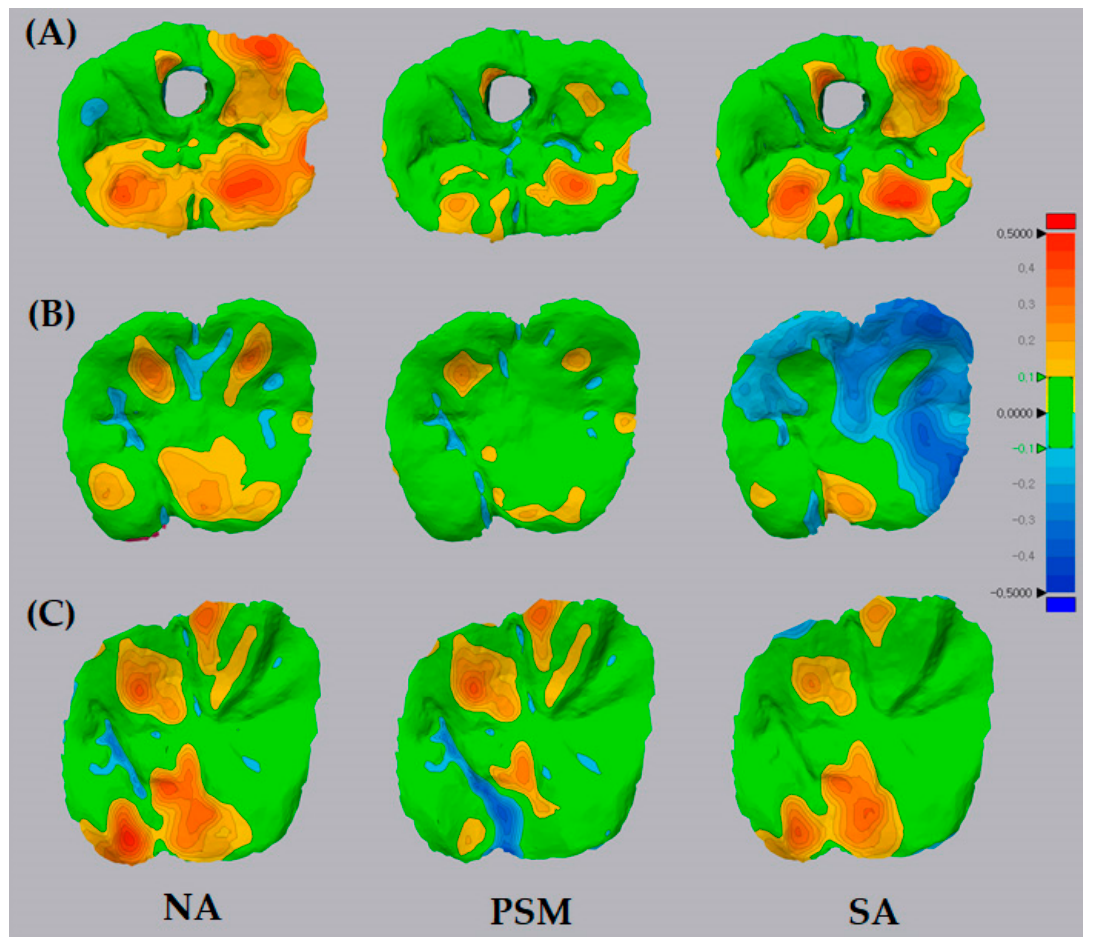
Figure 7. Representative images of the color-coded maps showing the deviations between the comparison data (NA, PSM, and SA) and the reference data (POST). The red-coded areas (i.e., positive deviation out of the tolerance range) suggested occlusal error that required clinical occlusal adjustment. ( A ) The PSM and SA groups showed less red-coded areas than the NA group. ( B ) In some cases, there were extensively blue-coded areas in the SA group, indicating over-correction. ( C ) Reduced red-coded areas were observed in different positions between the PSM and SA groups.